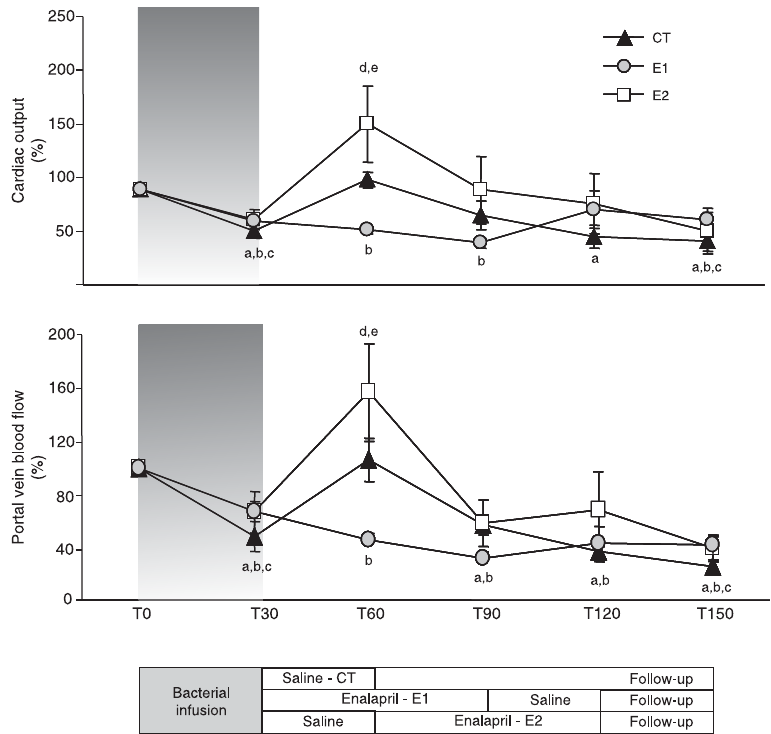
Figure 3. Cardiac output (%, mean ± SEM) and portal vein blood flow (%, mean ± SEM) during the experimental protocol. CT (control, N = 4) = fluid resuscitation (T30-T60) group; E1 (N = 5) = enalaprilat (T30-T90) + fluid resuscitation (T90-T120) group; E2 (N = 5) = fluid resuscitation (T30-T60) + enalaprilat (T60-T120) group. a CT, P < 0.05 vs T0; b E1, P < 0.05 vs T0; c E2, P < 0.05 vs T0; d P < 0.05 CT vs E1; e P < 0.05 E1 vs E2